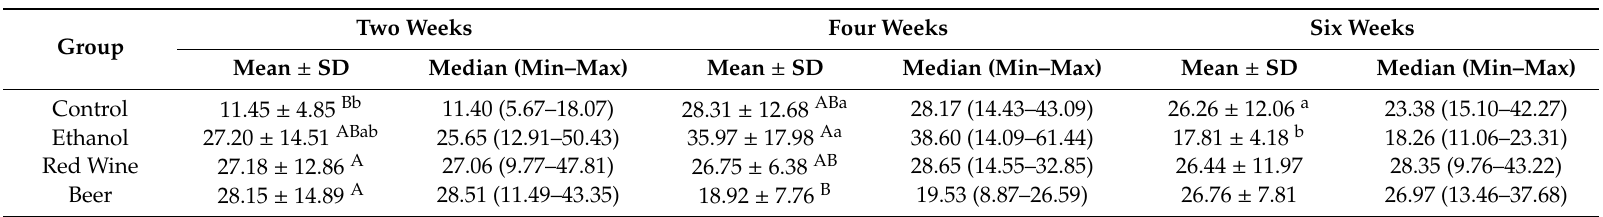
Table 7. Superoxide dismutase (SOD) activity (per mg of protein) in the groups of experimental rats stratified by a group and experiment